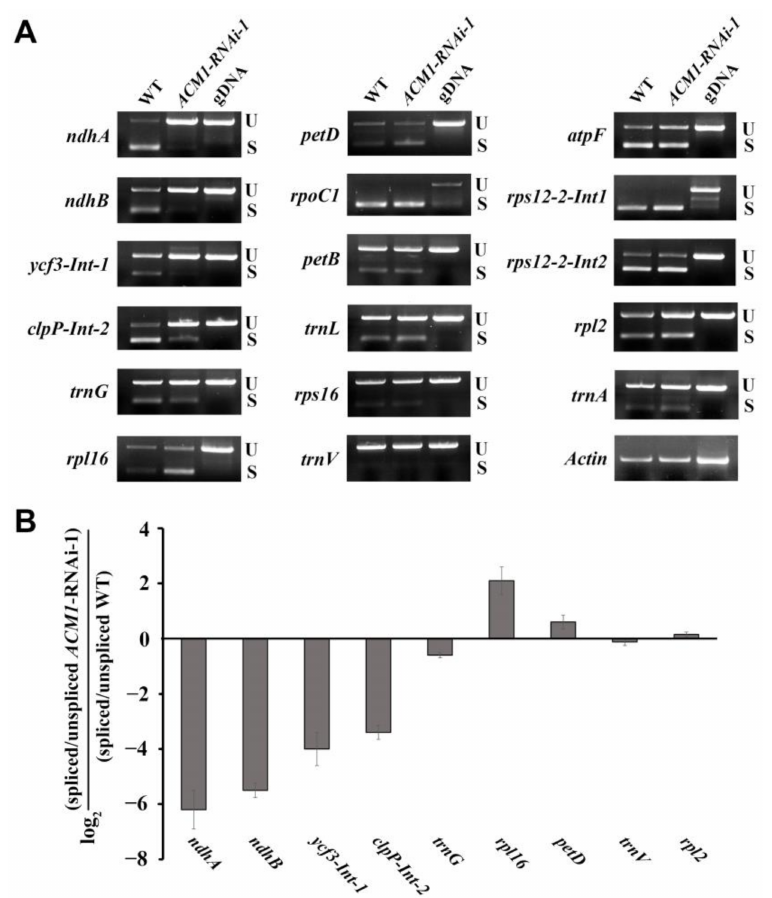
Figure 6. Splicing of several group II introns in the ACM1 -RNAi-1 chloroplast. ( A ) The splicing pattern of chloroplast intron-containing genes was analyzed by RT -PCR in the WT and ACM1 - RNAi-1 plants. Actin was considered a control. The experiments were repeated three times with similar results. The cDNA of WT and ACM1 -RNAi-1 was reverse-transcribed by total RNA from 7-day-old seedlings cotyledon. U, unsplicing; S, splicing. ( B ) Quantitative RT-PCR analysis to confirm the splicing efficiency of several transcripts as representative from ( A ). Data obtained from at least three independent experiments. RNA was extracted from 7-day-old seedlings cotyledons and